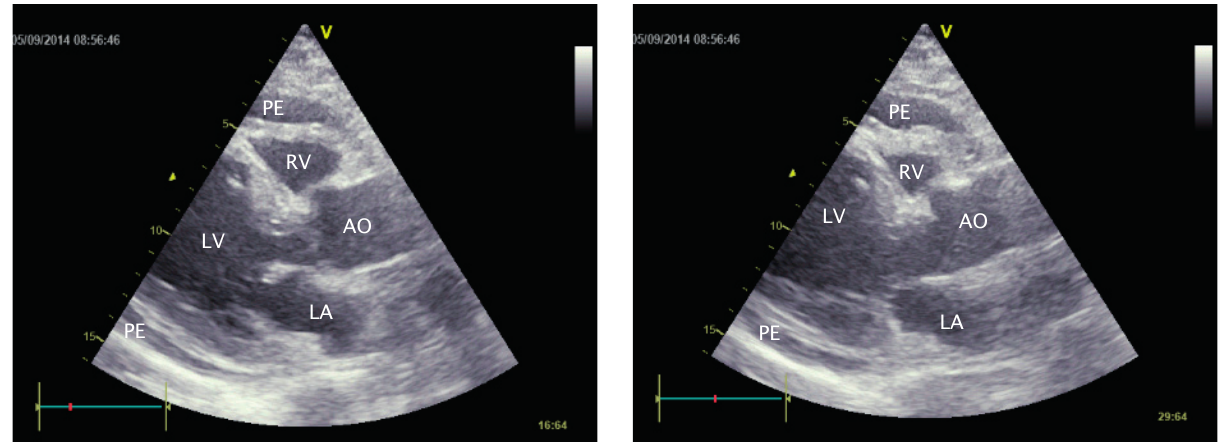
Fig. 4. Transthoracic echocardiographic images; still frames from parasternal long axis views (A – diastolic, B – systolic): severely impaired left ventricle systolic function with the estimated ejection fraction of 25%, pericardial effusion. AO, aorta; LA, left atrium; LV, left ventricle; PE, pericardial effusion; RV, right